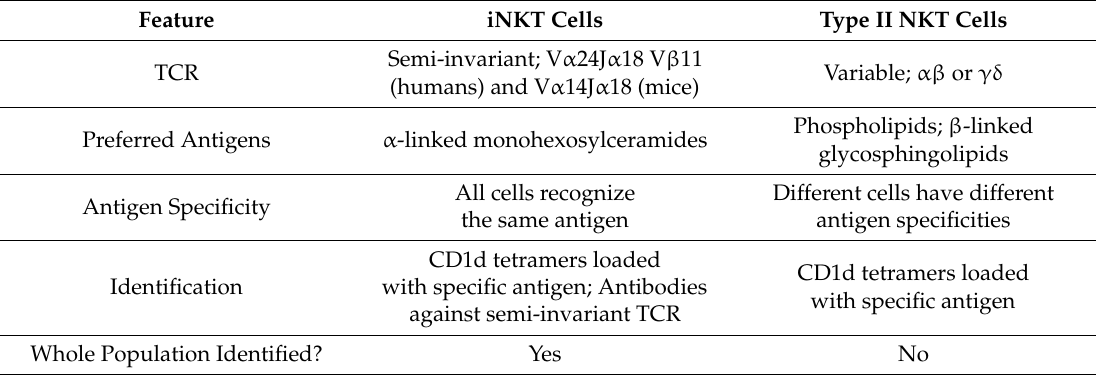
Table 1. Main differences between iNKT and type II NKT cells. NKT, Natural Killer T; iNKT, invariant NKT; TCR, T cell receptor; CD1d, cluster of differentiation 1